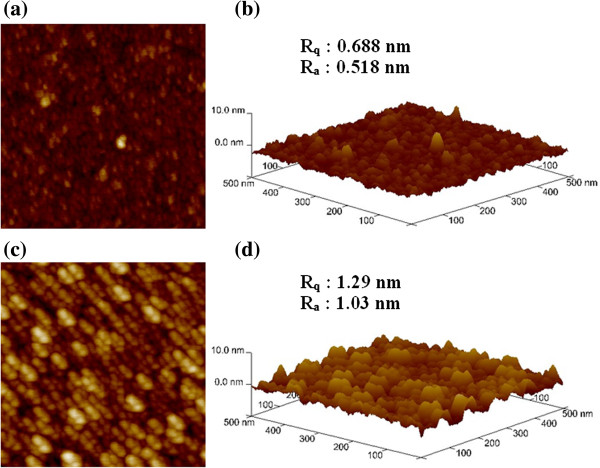
AFM images of the films. GdOx film on SiO2/Si substrate in (a) 2D and (b) 3D views. IrOx film on IrOx/GdOx/SiO2/Si stack in (c) 2D and (d) 3D views.